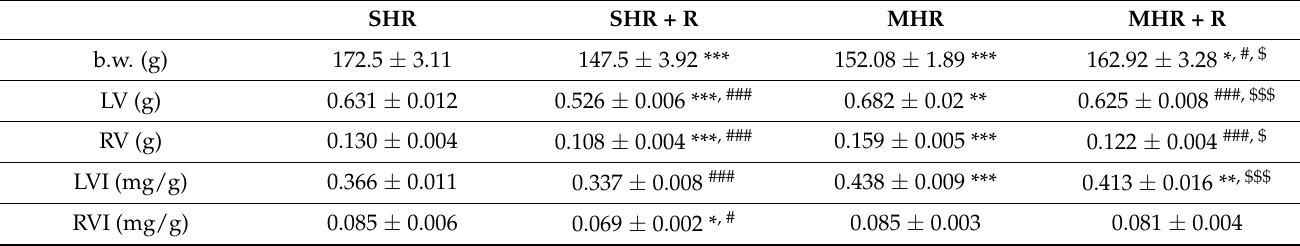
Table 1. Left and right ventricular (LV and RV) weight and weight indexes (LVI and